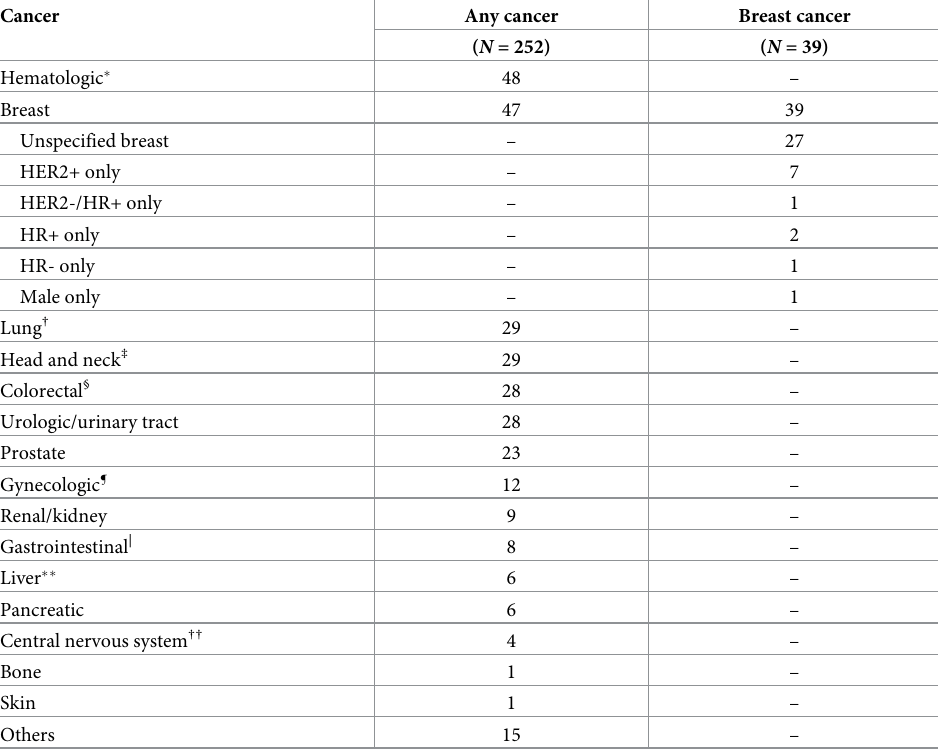
Table 1. Types of cancer evaluated in articles included in this review. Cancer Any cancer